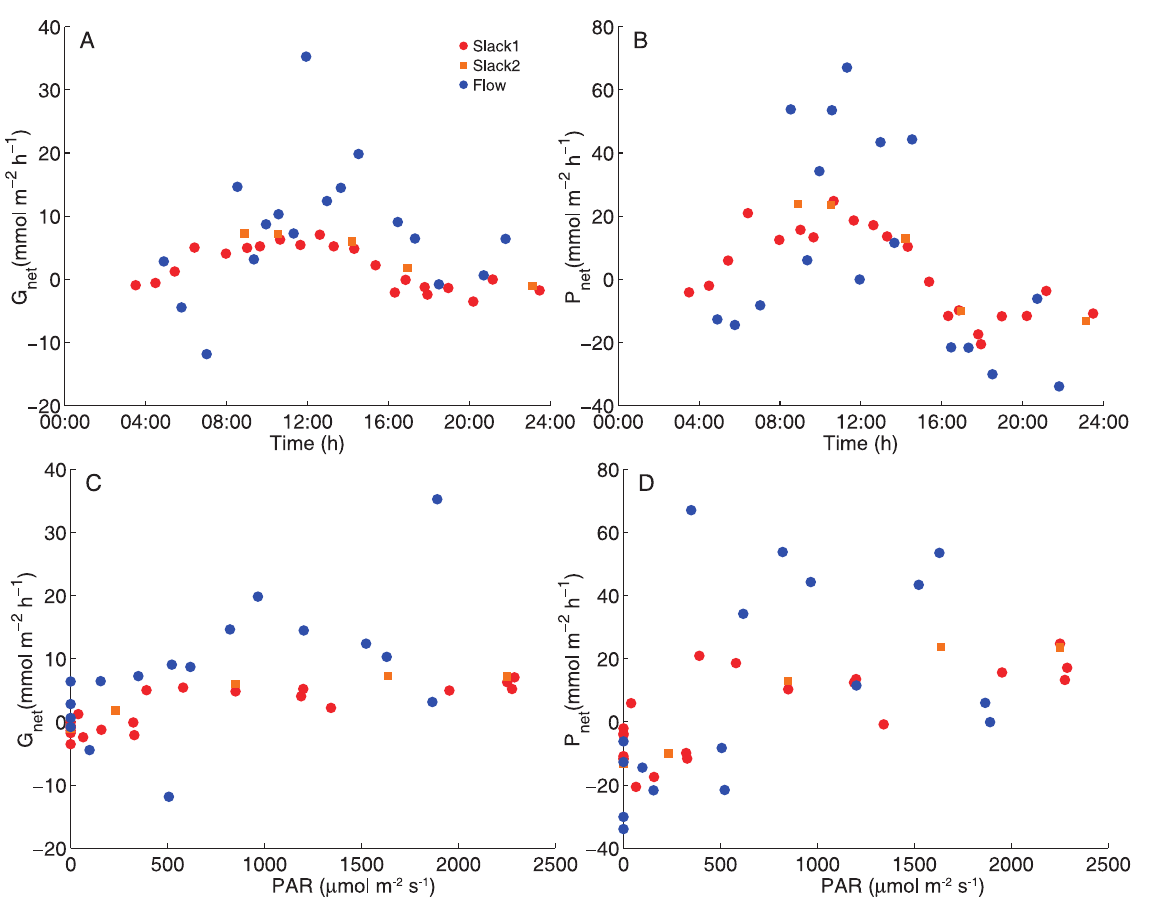
Figure 2. Variation of metabolic rates with time of day and PAR. (A) G net and (B) P net over time, and (C) G net and (D) P net versus PAR, for the slack water and flow respirometry methods, One Tree Reef flat, 8–22 November 2013. The main slack water sampling site is shown in red, the second slack water site in orange and the flow respirometry data shown in blue.